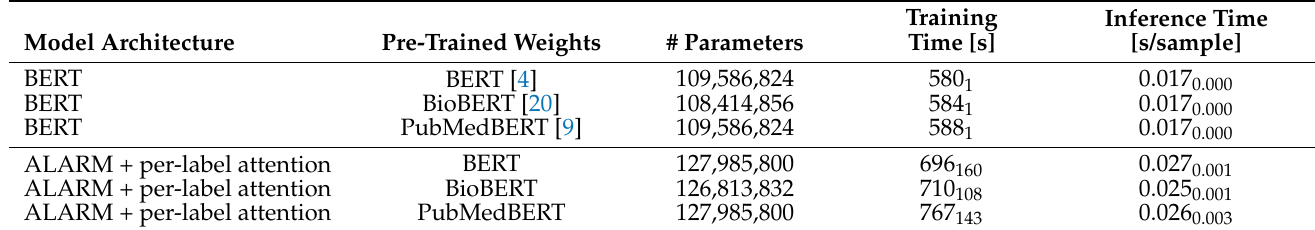
Table A1. Number of parameters, training time (over 838 samples) and inference time (per sample) for all models. All timings are given as mean standard deviation of 10 runs with different random